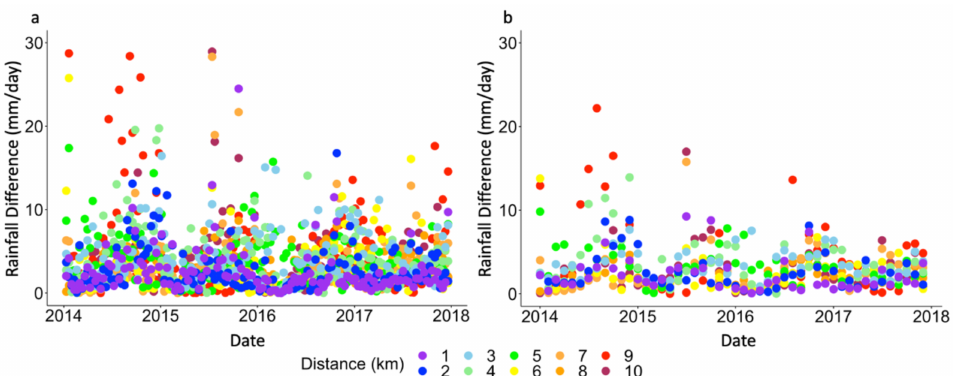
Figure 8. Absolute difference between ARGs and synoptic stations with respect to distances in their locations for ( a ) 10 day and ( b ) monthly rainfall